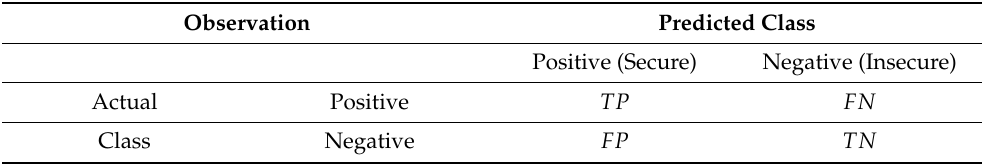
Table 1. Confusion matrix for TSA